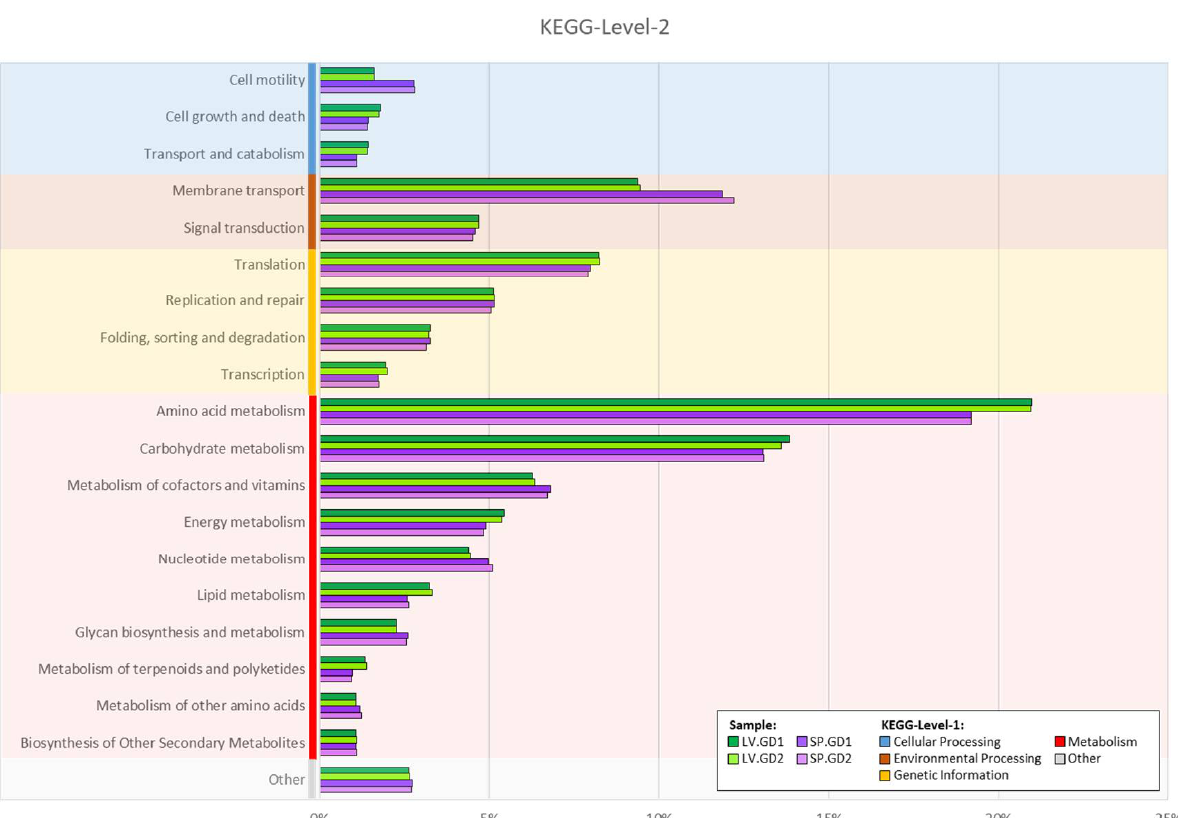
Figure 3. Relative abundance bar graphs were generated for each sample based on the KEGG-Level-2 categories determined through KEGG Orthology (KO) data following the MG-RAST (v4.0.3) workflow. KEGG-Level-2 categories were binned into their respective KEGG-Level-1 broad hierarchical functional category and ranked in decreasing order from top to bottom based on their average abundance. Each KEGG-Level-1 category was color-coded as follows: cellular processing = blue; environmental processing = brown; genetic information = orange; metabolism = red; and “other” = gray. The bar graphs for each sample have been color-coded and indicated as follows: SP.GD = purple sea urchin Strongylocentrotus purpuratus gut digesta; SP.GD1 = purple and SP.GD2 = light purple; LV.GD = green sea urchin Lytechinus variegatus gut digesta; LV.GD1 = green and LV.GD2 = light green.